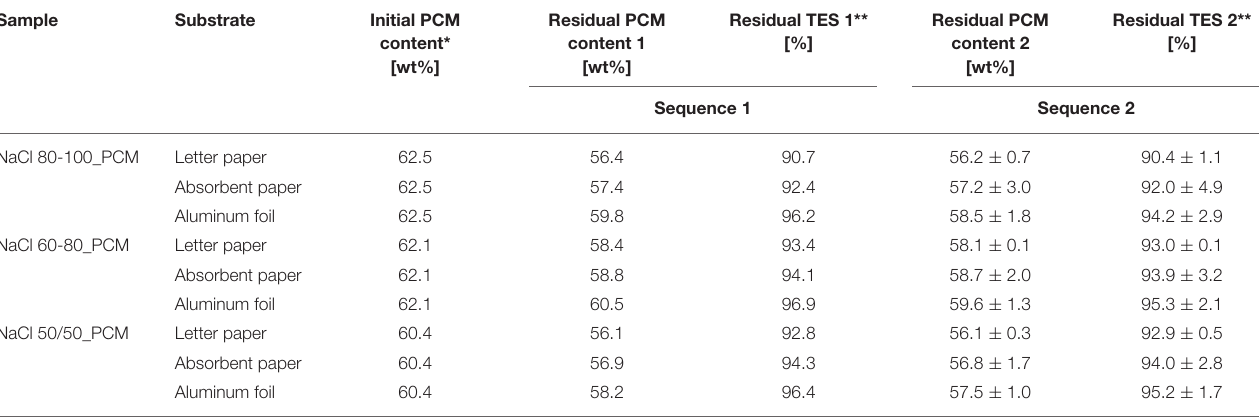
TABLE 7 | Results of the thermal cycling test of TES-EPDM foams stored on different substrates, following Sequence 1 (240 cycles between 0 and 40 ◦ C in 10 days) and Sequence 2 (storage at room temperature for 3 months, 40 ◦ C for 7h, and 0 ◦ C for 7h).